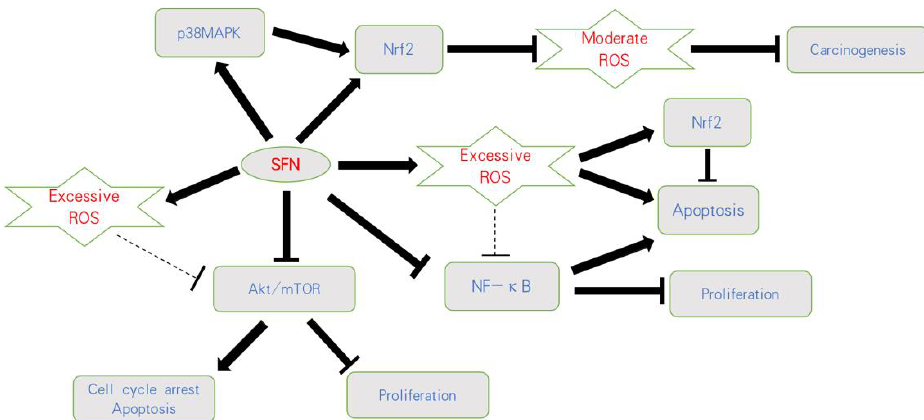
Figure 2. Influence of SFN on ROS-related pathways on bladder cancer. SFN blocks carcinogenesis by activating Nrf2 or the p38MAPK/Nrf2 axis and counteracting a moderate ROS-increase. Based on an initially excessive ROS level, SFN fur- ther increases ROS, resulting in apoptosis and proliferative inhibition. Nrf2 is thus considered a secondary product, fol- lowed by a ROS-increase involving anti-apoptotic properties. SFN also acts on the Akt/mTOR and NF- κB pathw ays, whereby the relevance of ROS as a trigger factor has not finally been validated; indicates activation; indicates inhibition; indicates not clear.